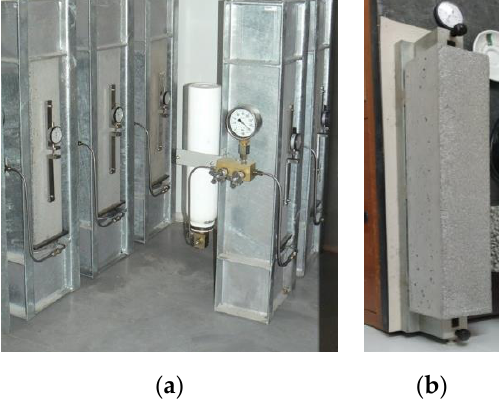
Figure 1. Compressive creep test ( a ) and total shrinkage test ( b ).